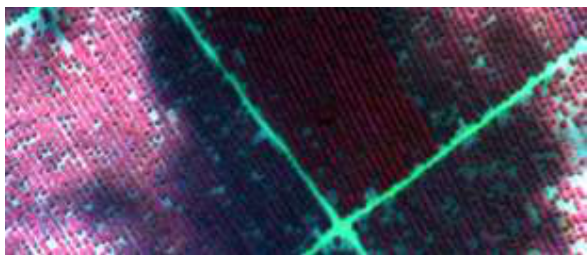
Figure 4. Color composition of LRcube: R 840.3 nm, G 660.5 nm and B 506.1 nm